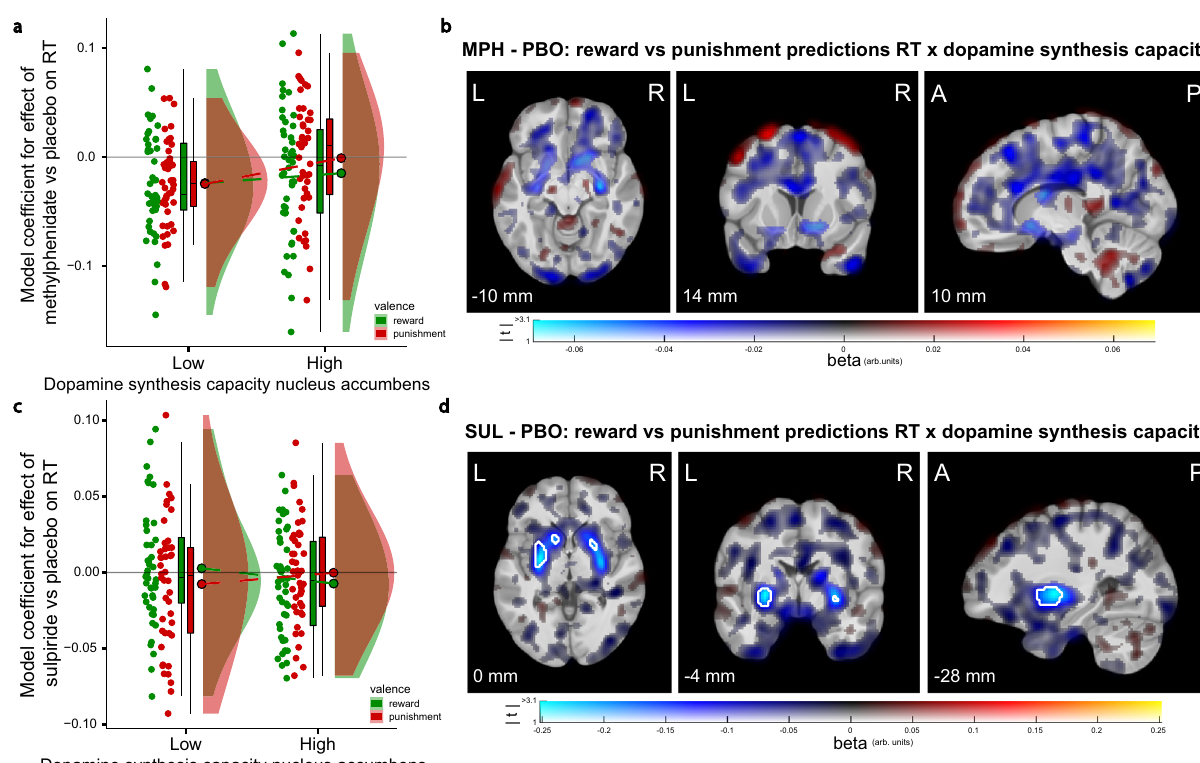
Fig. 6 | Relationship between striatal dopamine synthesis capacity and drug effects(relativetoplacebo)onrewardversuspunishmentpredictionresponse times. a Model coef fi cients for the effect of methylphenidate versus placebo on response times for only reward and only punishment predictions as a function of dopamine synthesis capacity in the nucleus accumbens (median split for visualiza- tion). b Voxel-wise covariation analysis of the PET k i cer data with individual